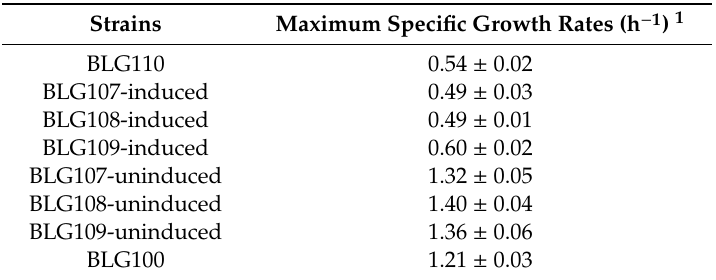
Table 3. Maximum specific growth rates of the recombinant